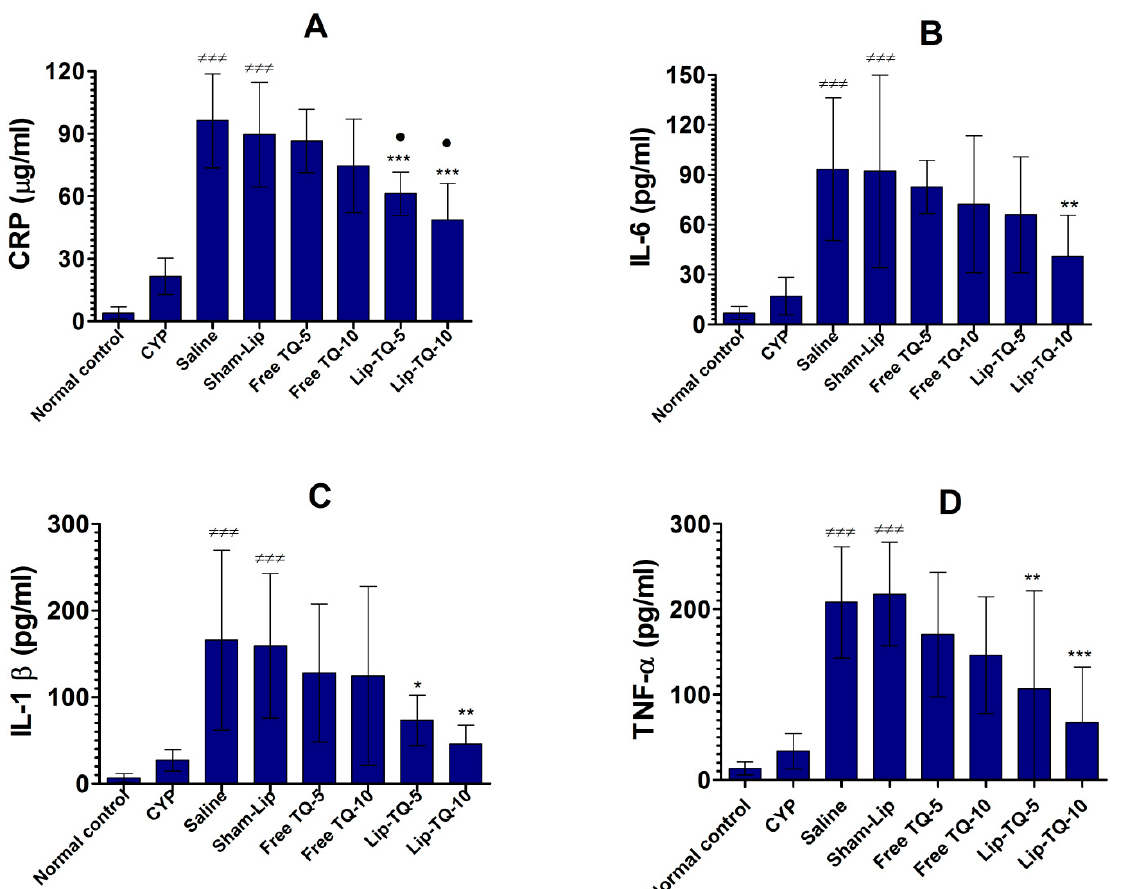
Figure 5. Treatment with Lip-TQ alleviated the systemic inflammation in A. baumannii -infected mice. ( A ) CRP. ≠≠≠ ( p < 0.001) CYP vs. Saline or Sham-Lip, *** ( p < 0.001) Sham-Lip vs. Lip-TQ-5 or Lip-TQ-10, ( p < 0.05) Free TQ-5 vs. Lip-TQ-5 or Free TQ-10 vs. Lip-TQ-10. ( B ) IL-6. ≠≠≠ ( p < 0.001) CYP vs. Saline or Sham-Lip, ** ( p < 0.01) Sham-Lip vs. Lip-TQ-10. ( C ) IL-1 β . * ( p < 0.05) Sham-Lip vs. Lip-TQ-5, ≠≠≠ ( p < 0.001) CYP vs. Saline or Sham-Lip, ** ( p < 0.01) Sham-Lip vs. Lip-TQ-10. ( D ) TNF- α . ≠≠≠ ( p < 0.001) CYP vs. Saline or Sham-Lip, Sham-Lip vs. Lip-TQ-5, ** ( p < 0.01), *** ( p < 0.001) Sham-Lip vs. Lip-TQ-10. The data are represented as the mean ± SD of three independent values. The data were analyzed by one-way ANOVA followed by the Turkey post-test.